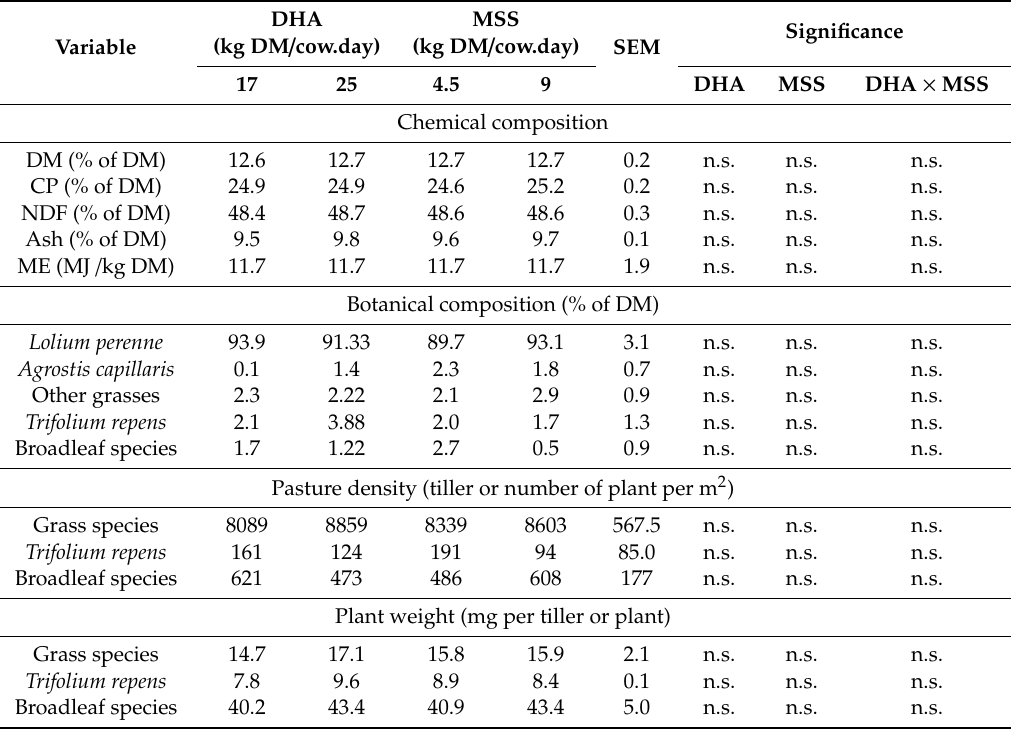
Table 3. E ff ect of daily herbage allowance (DHA) and maize silage supplementation (MSS) level on chemical and botanical composition, pasture density, and plant